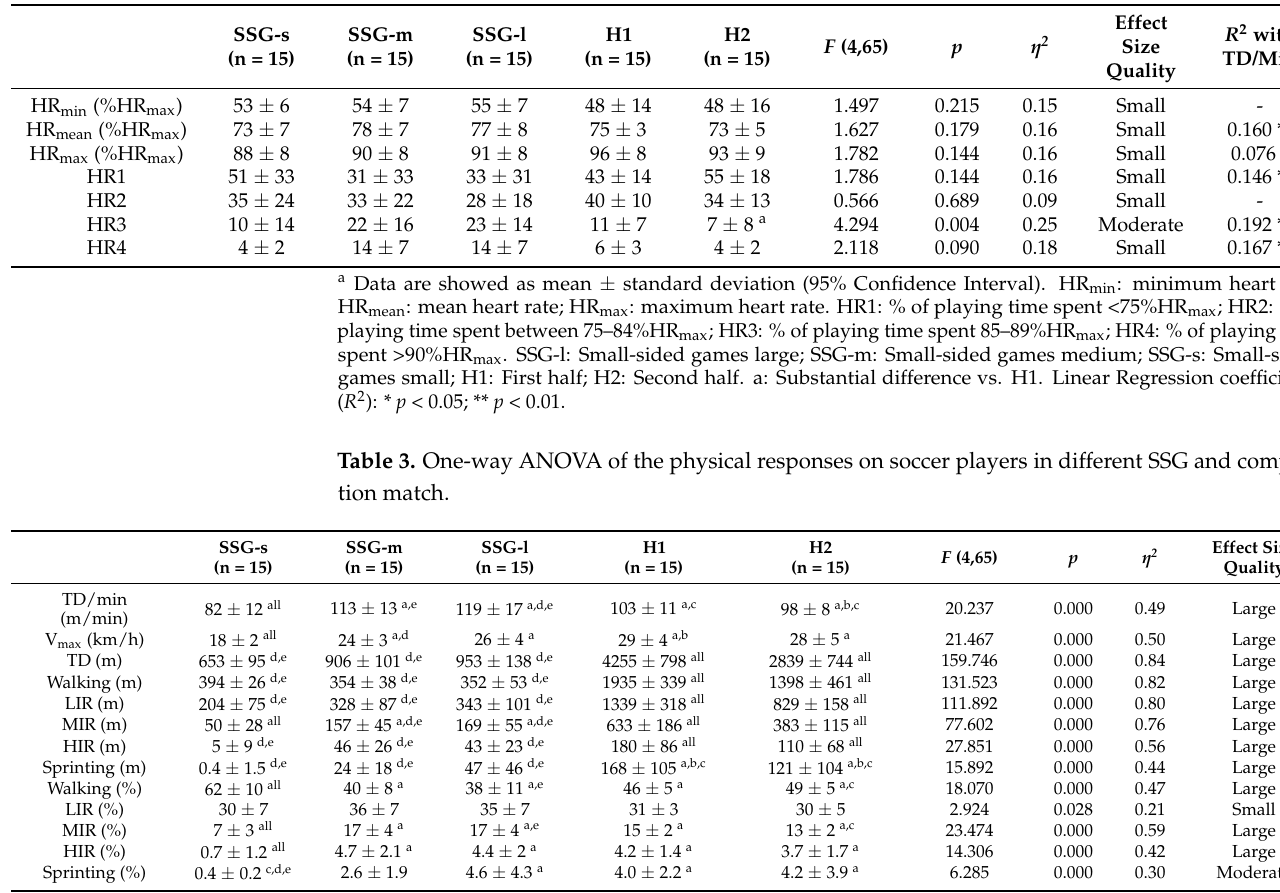
Table 2. One-way ANOVA of the physiological responses on soccer players in different SSG and competition match a . The final column shows the regression coefficient between distance per minute and the physiological metrics.